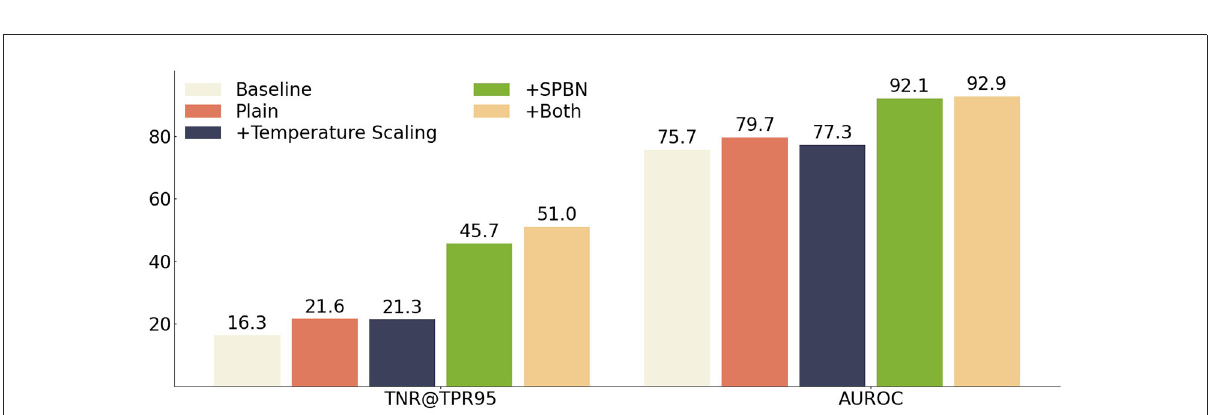
FIGURE4 The effects of SPBN, temperature scaling SMOOD data are demonstrated, using both TNR@TPR95 and AUROC metrics. The feature extractor is trained using ResNet as the bone network, using the method proposed in this paper. The ID, OOD datasets for training and testing the model use Cifar100 and Cifar10,